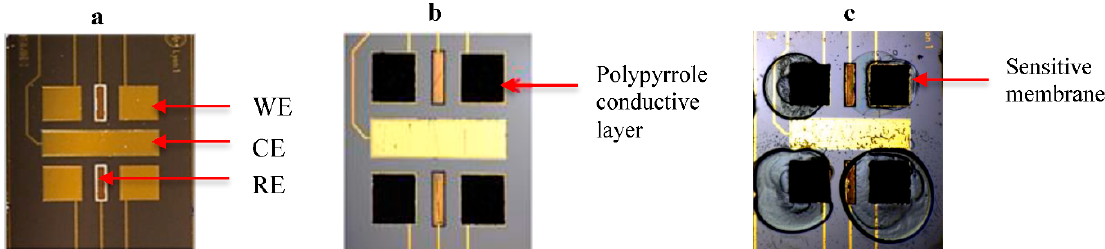
Figure 1. ( a ) transducer holding an array of four gold working microelectrodes (WE), one gold counter microelectrode (CE) and two Ag/AgCl reference microelectrodes (RE). ( b ) WEs electrochemically modified with polypyrrole solid contact layer. ( c ) the polymeric membrane drop-cast on the top of the PPy modified working microelectrodes.